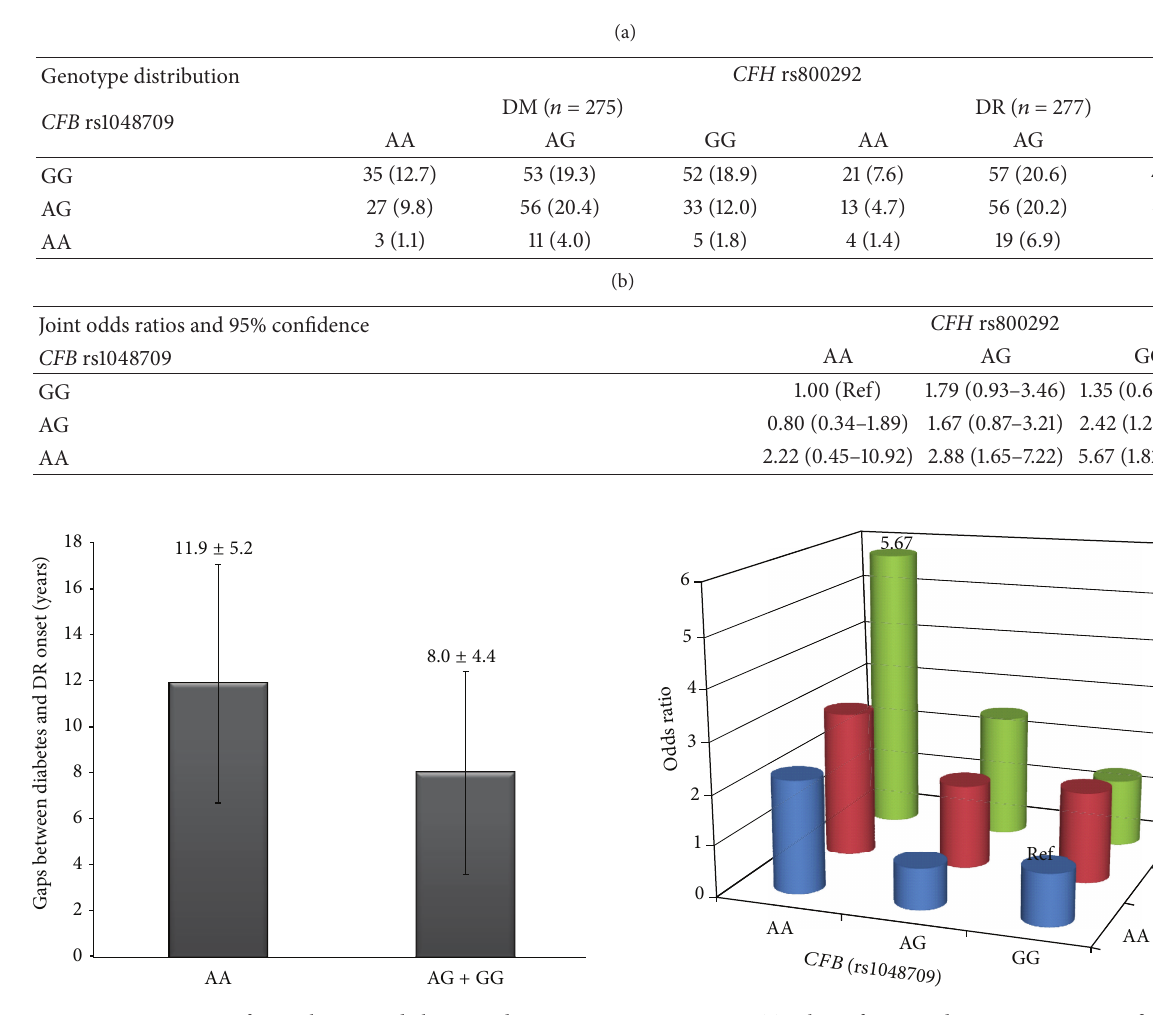
Figure 3: Two loci of CFH and CFB genotype-specific DR risk. genetic associations of variants in CFH and CFB with DR have not been described